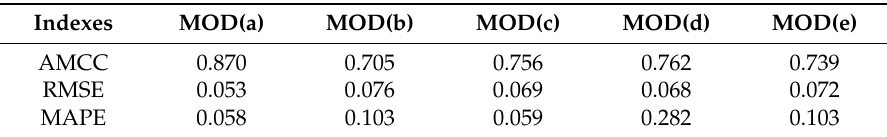
Table 1. The AMCC, RMSE, and MAPE values for the five